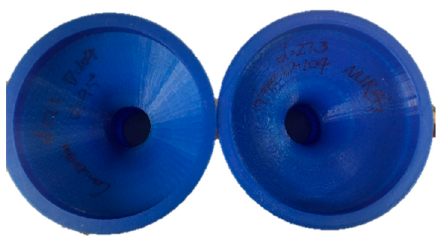
Figure 3. The shapes of the conventional cone and the nonuniform rational B-splines (NURBSs) cone.